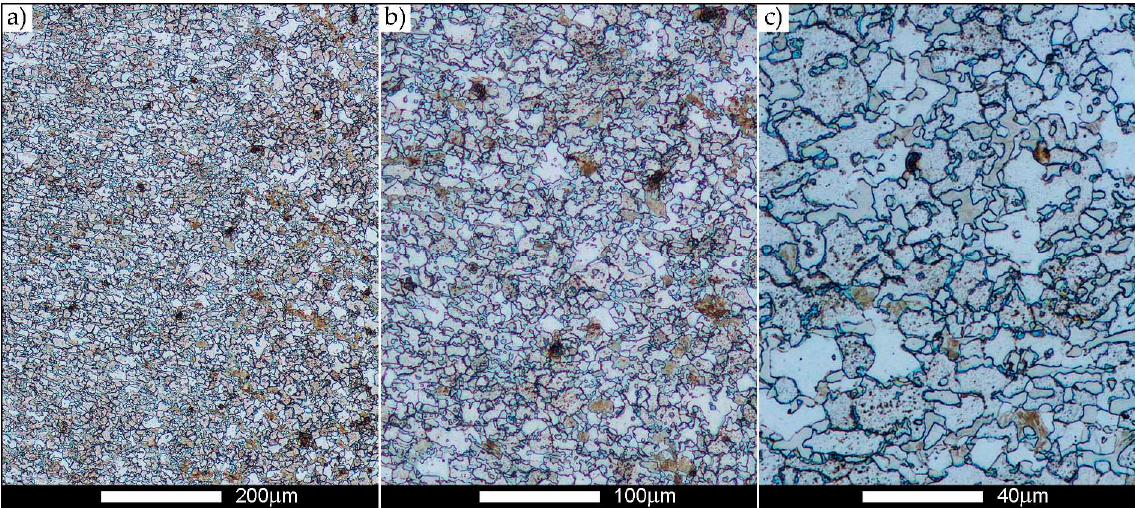
Figure 45. Welded joint microstructure of Hardox 450 steel with visible prior austenite grain boundaries, austenitised at 900 °C—WM3 zone shown in Figure 2. ( a ) 100×; ( b ) 200×; ( c ) 500×.